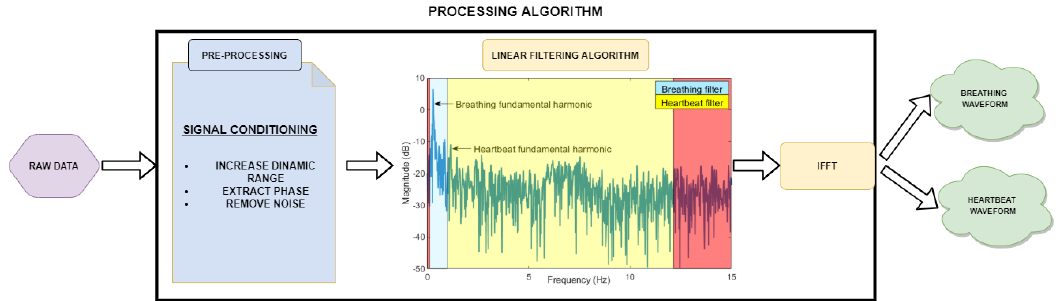
Figure 7. Block diagram showing the modules used to separate the breathing and heartbeat waveforms.